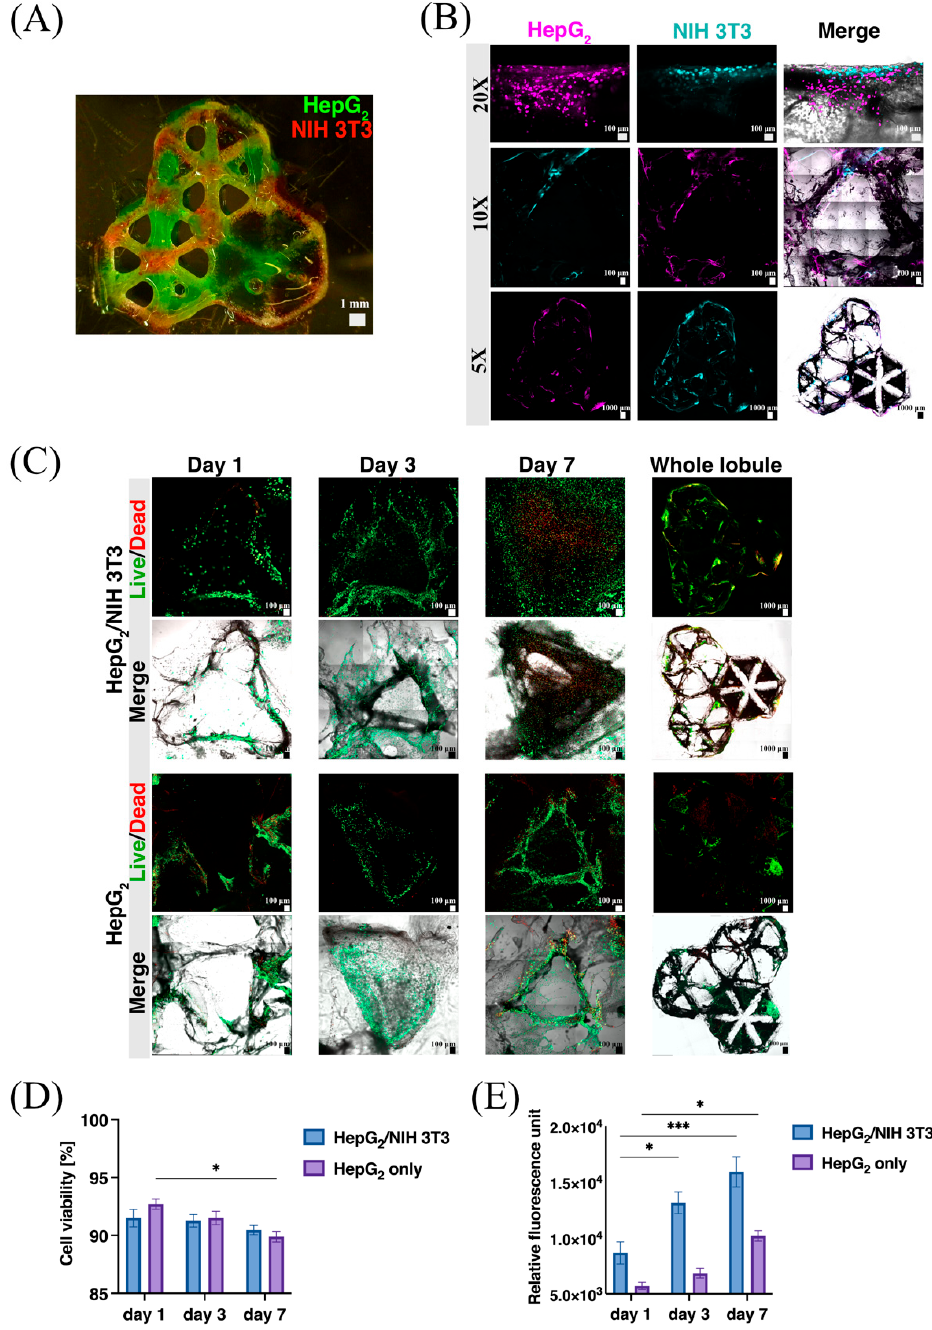
Figure 4. Cell biocompatibility and viability study. ( A ) Representation of co-culture of HepG 2 (green) and NIH 3T3 (red) cells in the dLM-PEG-T trilobular structure. ( B ) Microscopic images of CellTracker labeled HepG 2 and NIH 3T3 cells embedded in dLM-PEG-T with 20 × and 10 × magnification (scale bar 100 µ m) together with the whole lobule (scale bar 1000 µ m) at day 3 represented in different fluorescence channels. ( C ) Live/dead assay microscopic images on days 1, 3, and 7 (scale bar 100 µ m) with the whole trilobular structure on day 7 (scale bar 1000 µ m) compared to the monoculture of HepG 2 cells. Comparison of co-culture of HepG 2 /NIH 3T3 with only HepG 2 cells by ( D ) cell viability ( n = 3, * p < 0.05) and ( E ) alamarBlue TM assay at days 1, 3 and 7 ( n = 3, * p < 0.05 and *** p < 0.001). Error bars represent the standard error of the mean.